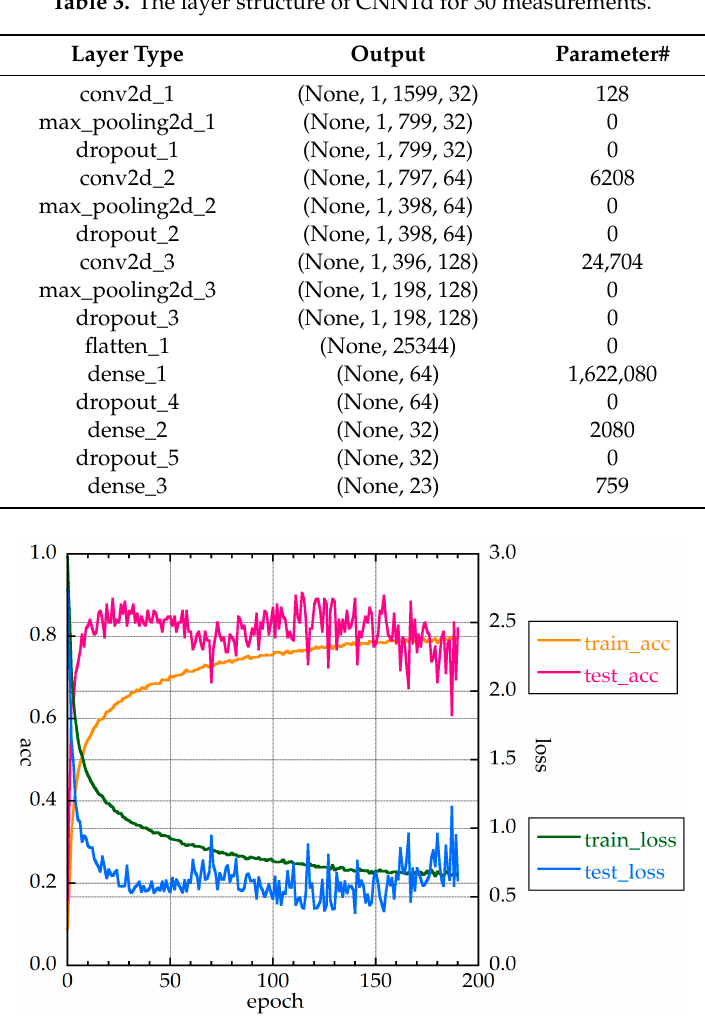
Geosciences 2019 , 9 FOR PEER REVIEW Figure 7. Accuracies and loss function values of CNN1d for 30 measurements without HQ.